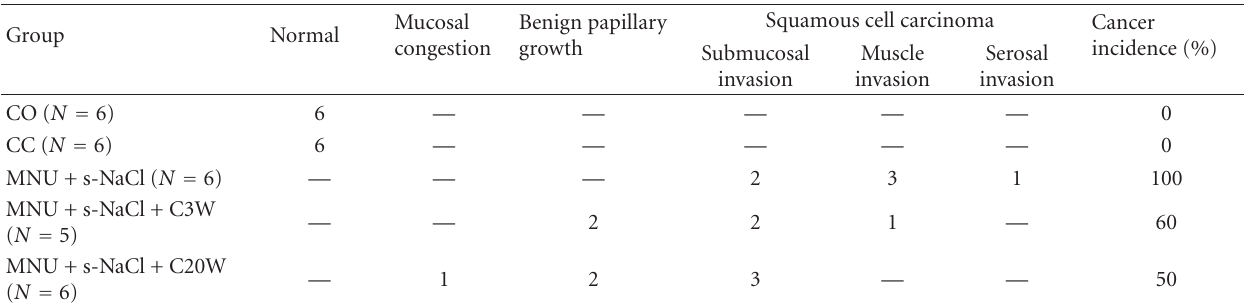
Table 1: Histopathological changes of gastric mucosa in the experimental groups. Mucosal Benign Normal congestion